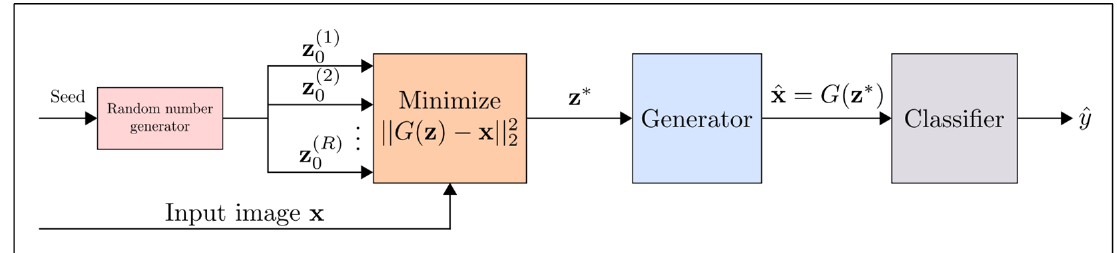
Figure 17. Overview of the Defense-GAN algorithm (Image Credit: Samangouei et al.